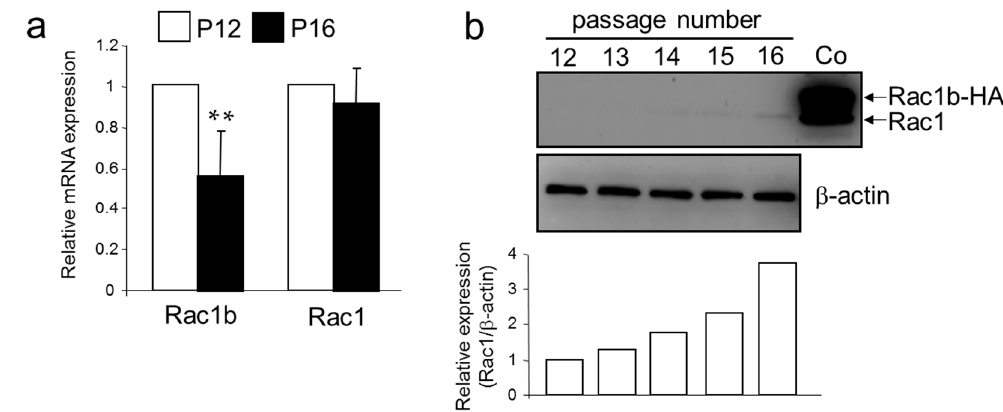
Figure 4. Rac1b and Rac1 expression in HMEC of different passage numbers. ( a ) qPCR-based measurement of Rac1b and Rac1 expression in P12 and P16 HMEC. Data are the mean ± SD of three experiments ( n = 3) and those from P16 HMEC are expressed relative to those in P12 HMEC set arbitrarily to 1.0; ( b ) Immunoblot-based measurement of Rac1 in HMEC of different passage numbers as indicated. As control (Co), a lysate from the pancreatic cancer cell line Panc1 ectopically expressing Rac1b-HA was used. A densitometric analysis of underexposed replicas is shown below the blots. Data are representative of three experiments.